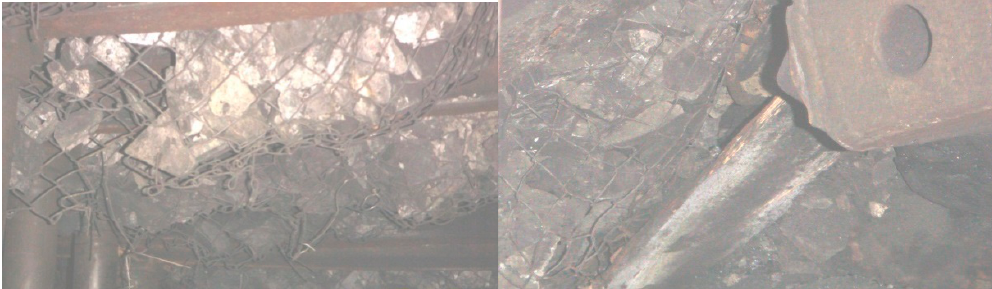
Figure 8. Artificial roof support in the air-return gateway and caved rocks right behind the face end shields.